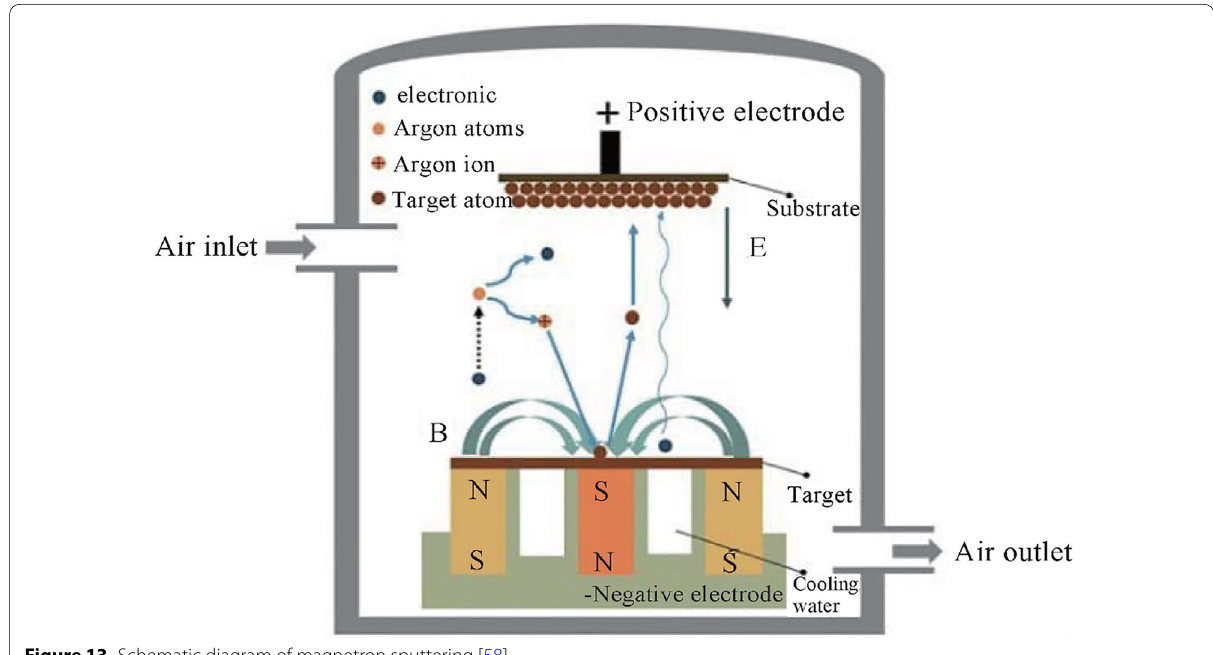
Figure 13 Schematic diagram of magnetron sputtering [58]